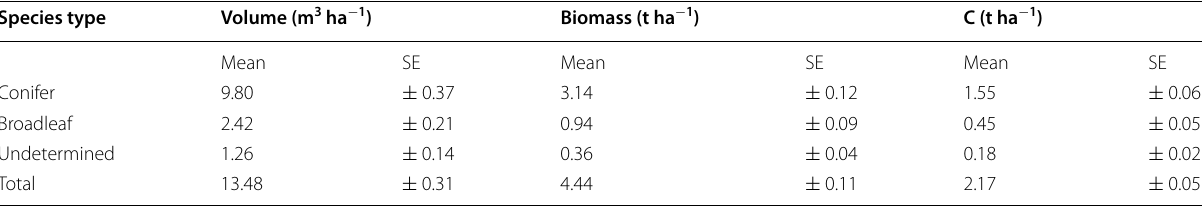
Table 2 Mean SE of the volume, biomass, and C stocks based on the NFI5 stump inventory including all measured stumps, cf. ± Fig. 3b. The data are based on sample plots in the NFI that are common to all five NFIs Species